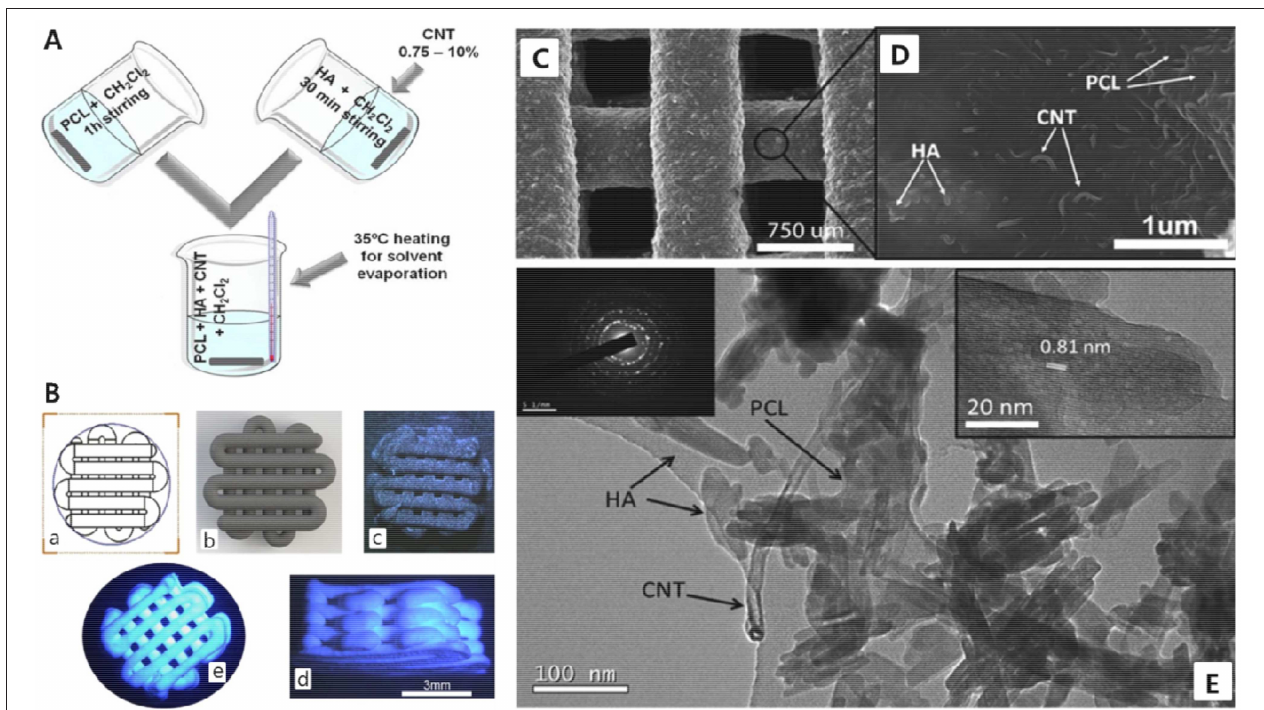
FIGURE 8 | (A) Schematic representation of the preparation of slurry. (B) Technical model (a), 3D simulation of this model (b), PCL(50)/HAp(40)/CNT10 printed scaffold (c), and PCL(50)/HAp(50) printed scaffold [side view (d) and top view (e)]. (C) SEM image of PCL(50)/HAp(40)/CNT10 printed scaffold and (D) composite surface at higher magnification of SEM image. (E) TEM image of the composite (inset: left side is electron diffraction pattern of HAp NPs and right side is high-resolution image of a crystal of HAp). Reproduced from Gonçalves et al. (2016) with permission from Wiley Periodicals,